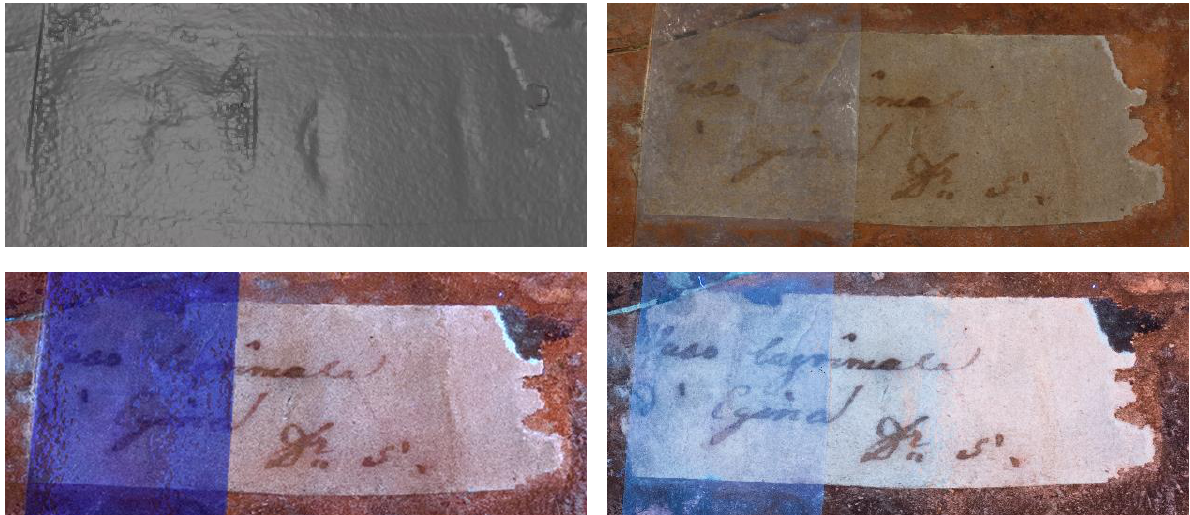
Figure 8. Detailed views of the vase label from the mesh model showing the geometry (a) and the three different texture mapping: VIS (b), UVL @ 254 nm (c), UVL @ 366 nm (d).